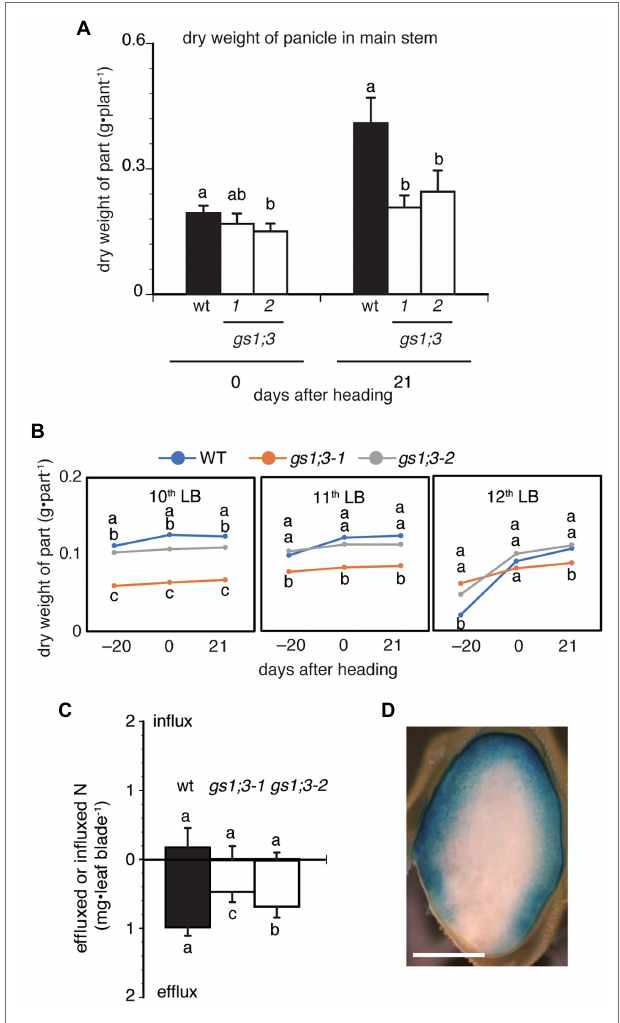
FIGURE 7 | Influx and efflux of nitrogen in the 12th leaf blade on the main stem and GS1;3 promoter activity in ripening grains. (A) Dry weight of main stem panicles, and (B) dry weights of the 10th to 12th leaf blades of WT and GS1;3 mutant plants grown in hydroponic culture with 0.5 mM NH 4+ are shown. For (A,B) , plant organs were harvested 19 days before heading, at heading, 20 days after heading. (C) The influx and efflux of nitrogen in WT and GS1;3 mutant plants in the 12th leaf blades at 61 days after heading. Plants were grown in hydroponic culture and were supplied with 15 N-labeled NH 4 Cl for 5 days from 19 days before heading onwards. Significant differences within each group were determined using one-way ANOVA followed by Bonferroni tests and are indicated with different letters ( p < 0.05). Data represent mean ± SD ( n = 8, for wt, gs1;3-1 , and gs1;3-2 ; D ) GS1;3 promoter-driven GUS activity in ripening rice grain. Transgenic plants expressing GS1;3pro::GUS were grown in the greenhouse on fully fertilized soil. Ripening grains were harvested at 35 days after heading and used for GUS staining. The transverse section is shown. Bar indicates 1